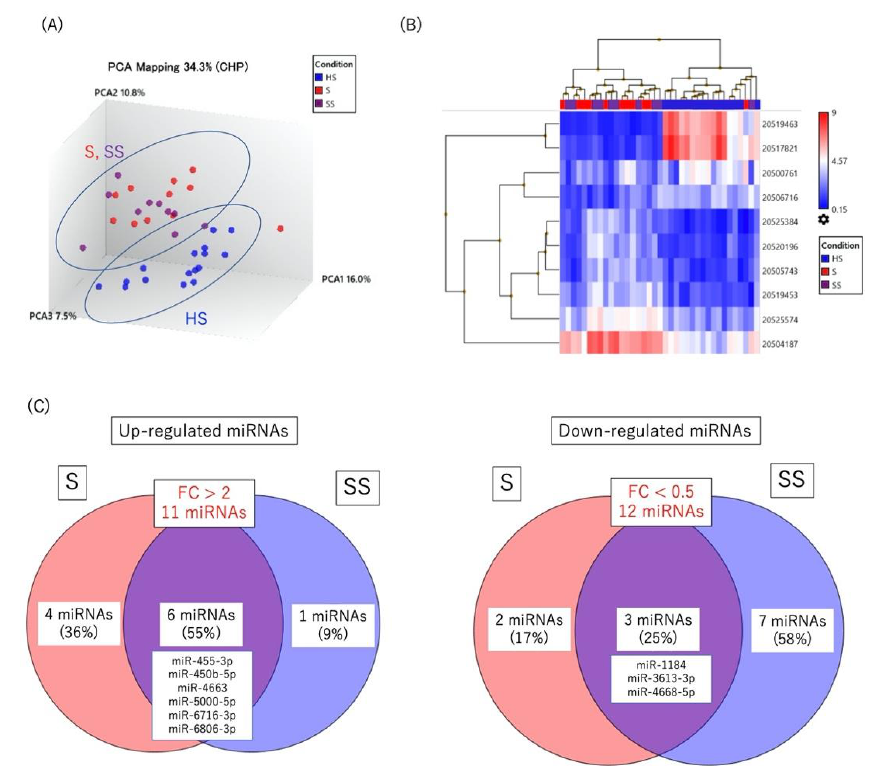
Figure 3. ( A ) Principal component analysis, ( B ) unsupervised hierarchical clustering analysis, ( C ) Venn diagrams showing miRNAs significantly up-regulated (>2.0-fold change) or down-regulated (<0.5-fold change) in diagnosed ocular sarcoidosis or suspected ocular sarcoidosis compared to healthy control subjects ( p < 0.05). FC: fold change, HS: healthy subjects, S: diagnosed ocular sar- coidosis, SS: suspected ocular sarcoidosis.